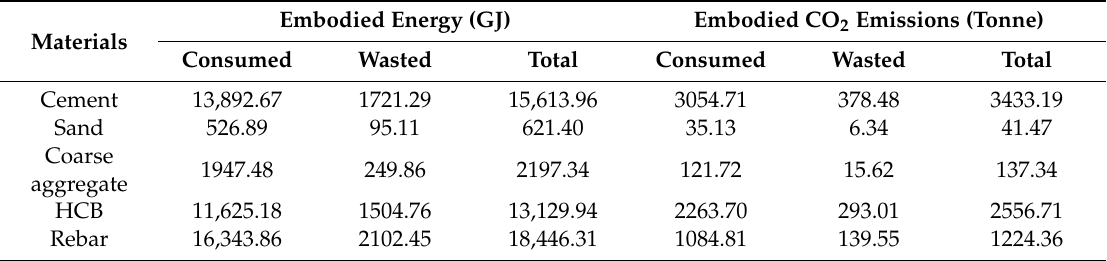
Table 4. Quantities of the embodied energy and CO 2 emissions of the individual